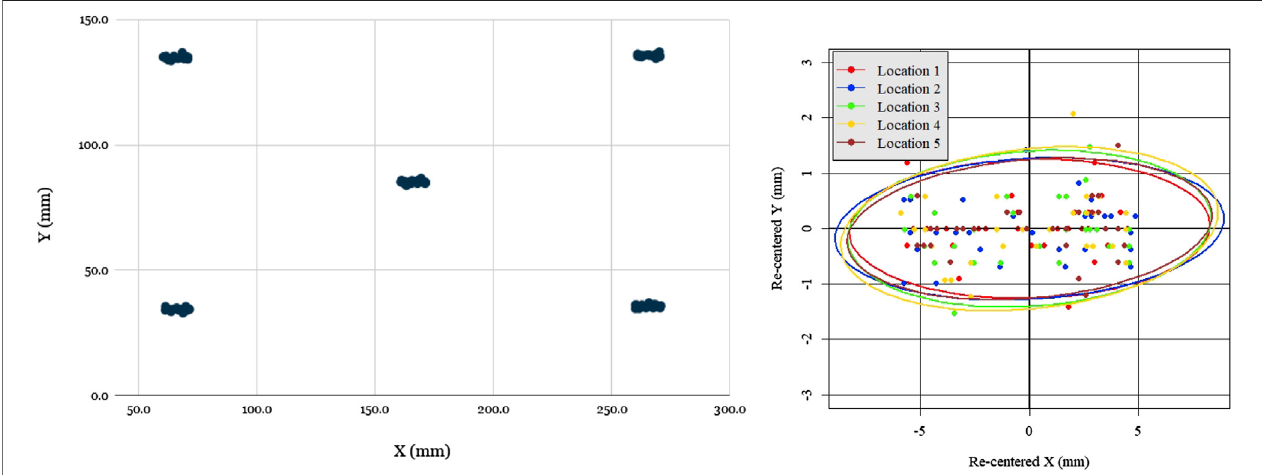
FIGURE6| Evaluation ofrobot open looprepeatability:scatter plotofopen-looprecordedtapsfor fi ve locationsdistributedacrossthescreen (left) ,scatter plotof all tap locations re-centered with respect to each barycenter with 95% con fi dence covariance ellipses for each location. Notably, the spread of re-centered locations is approximately the same across all locations, as evidenced by the covariance ellipse overlap, but spread is greater in X than in Y.